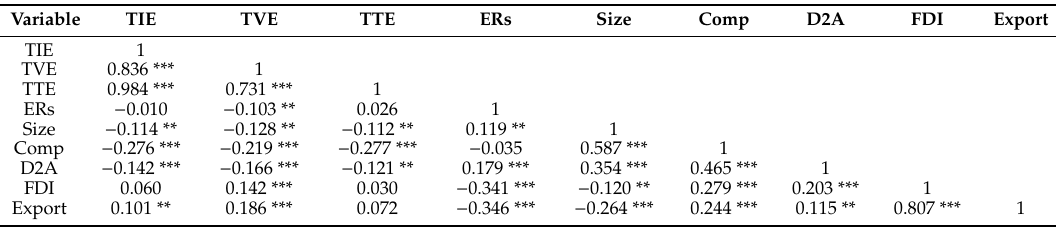
Table 5. Correlation coe ffi cients of all variables.